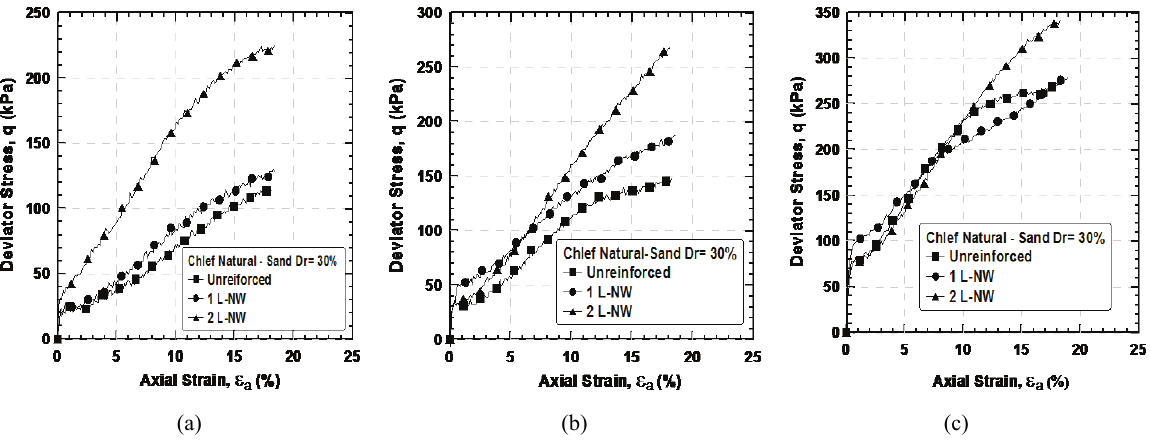
Fig. 8. Deviator stress versus axial strain curves of sand samples reinforced with various number of geotextile layers under different confining pressures: (a)